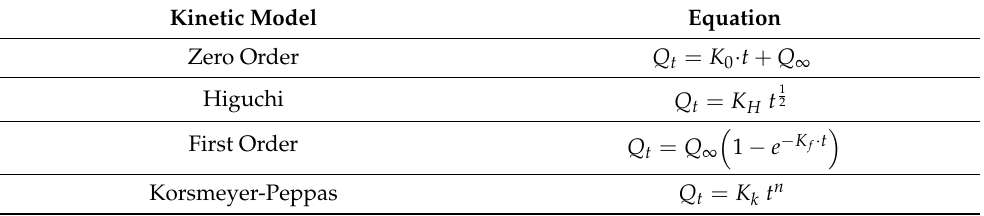
Table 7. Kinetic model equations used for the Donepezil release